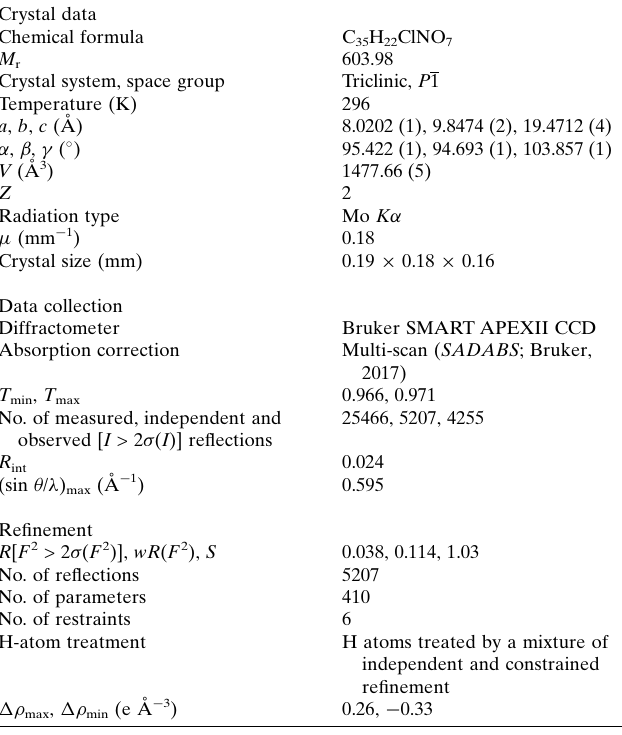
Table 2 Experimental details. Crystal data Chemical